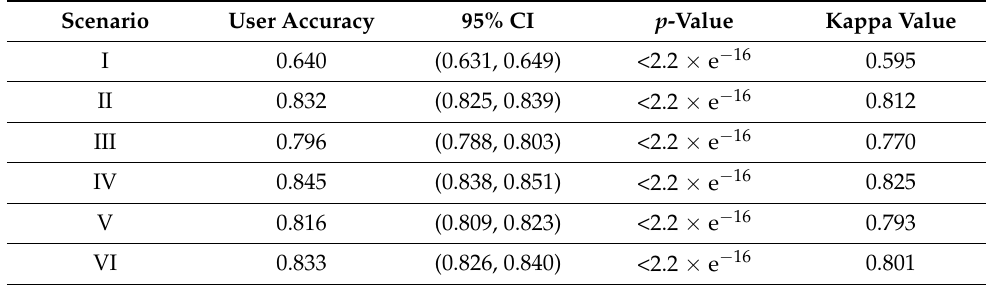
Table 4. Overall Results of Random Forest Model by